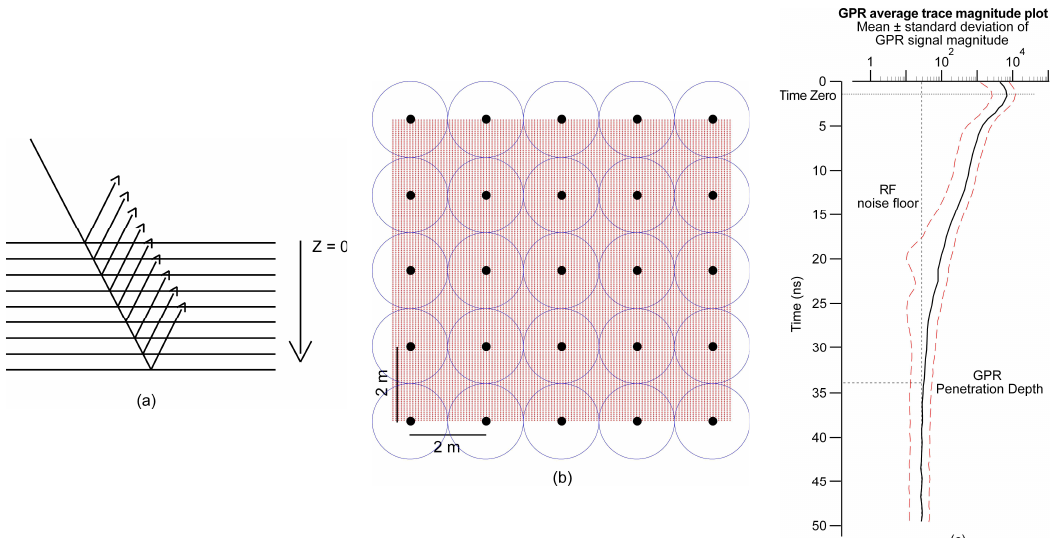
Figure 4. Illustration showing the procedure for calculating average global and localized 3D-GPR penetration depths: ( a ) equal reflectivity layered earth model, ( b ) 2 x 2 m 2 regular grid points (black) and circles with 1 m radius (blue) overlain on densely sampled 3D-GPR data (red), and ( c ) average GPR trace magnitude plot as a function of time with background radio frequency noise floor and GPR penetration depth. The solid black line corresponds to the mean and the dashed red lines correspond to the mean ± standard deviation of the GPR signal magnitude. Note the logarithmic scale used to express the magnitude mean and standard deviation